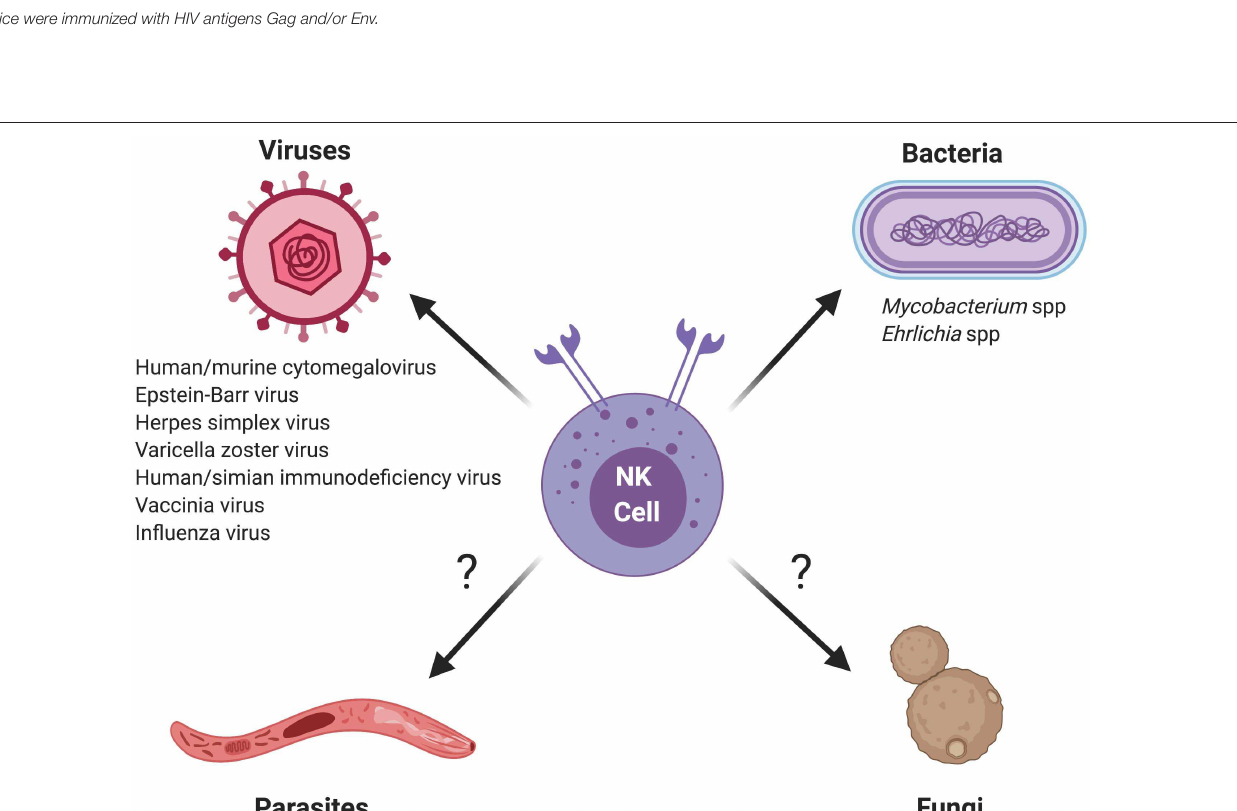
Frontiers in Cellular and Infection Microbiology |